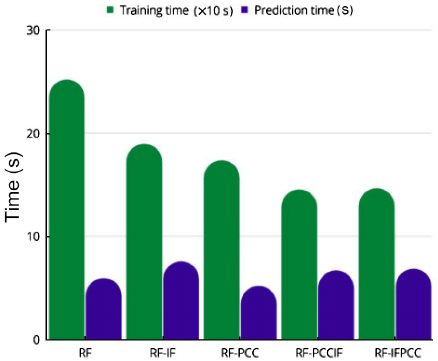
Fig. 10 Summary of performance metrics on the NF- UNSW-NB15-v2 dataset.